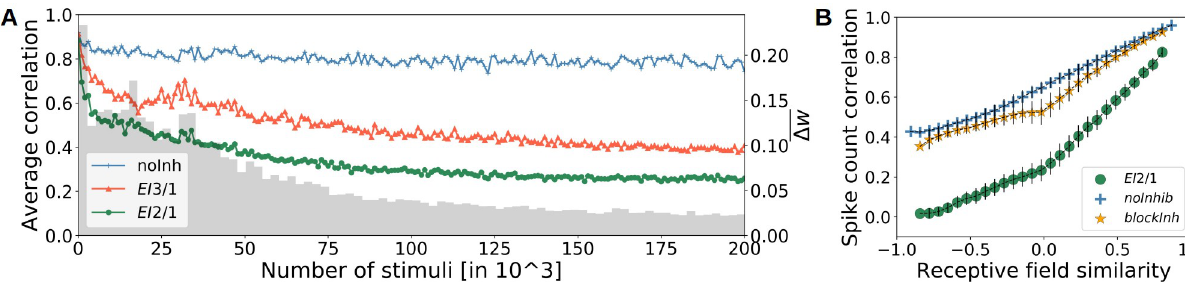
Fig 5. Inhibitory strength influences the response decorrelation. A The development of mean response correlation and weight change at the LGN excitatory synapses across learning. Stronger inhibition, in the EI 2/1 model, leads to a stronger decorrelation of the neuron responses during learning (compare green with red ( EI 3/1) line). Mean response correlation changed only very slightly without inhibition (blue line). The change in the synaptic weights (gray bars) decreases over the developmental process, indicating the emergence of stable receptive fields. B Response correlation is higher for neurons with more similar receptive fields. Blocking inhibition (yellow line) after learning reveals that inhibition leads to a overall decrease of the response correlation (green line).